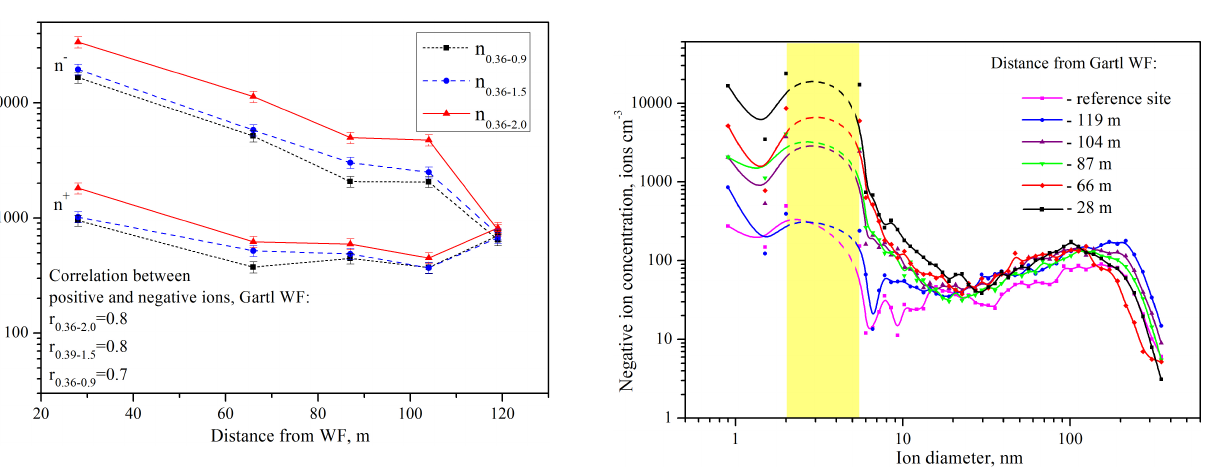
Fig. 13. Ion concentration distribution by size, measured at different distances on 3 July 2010 at Gartl WF, D¨ollach. Shaded area indi- cates interpolated values (cubic B-spline) between CDI-06 (0.36– 2.0nm) and SMPS (5.5–350nm) measurements. The reference site data series (magenta curve) represents the reference site where no WF-generated ions were expected to